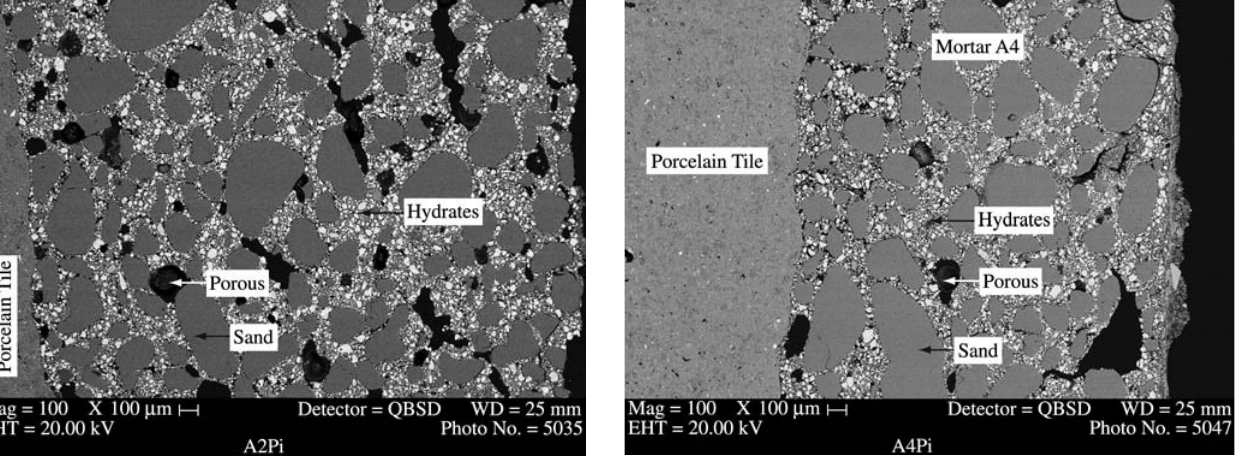
Figure 4. Backscattered electron micrograph of the polished surface. showing the interface between porcelain tile and mortar containing 5% silica fume and 20% latex.